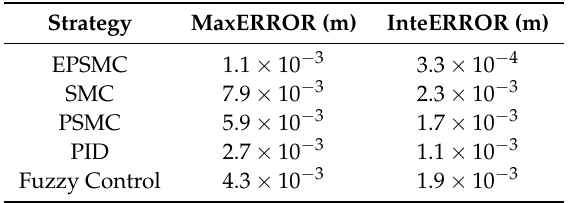
Table 2. The tracking performance of different control